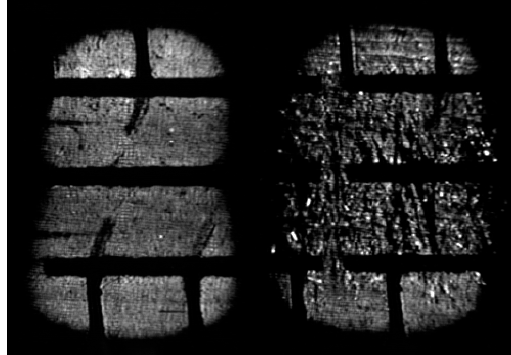
Figure 28. Pressure distribution: before ( left ); and after ( right ) the defect was produced.